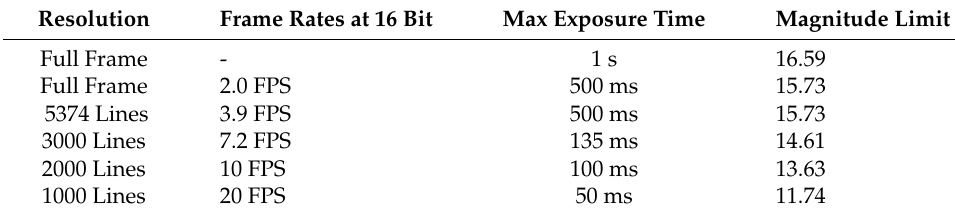
Table A1. Frame Rate For QHY411 with Optical Fibre.